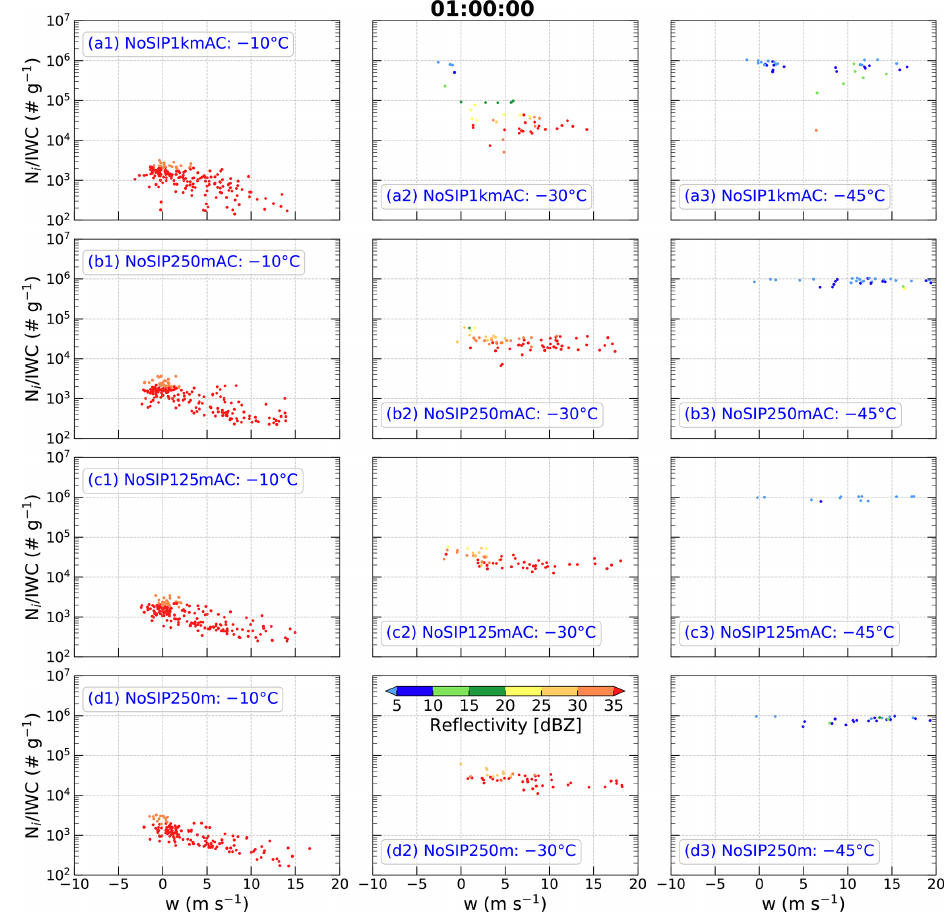
Figure 4. Scatter plots of simulated ice number concentration ( N i , no.m − 3 ) divided by ice water content (IWC, gm − 3 ) (denoted as N i / IWC) as a function of vertical velocity ( w , ms − 1 ) in regions with IWC > 1gm − 3 at temperatures of (left column) − 10 ◦ C, (middle column) − 30 ◦ C, and (right column) − 45 ◦ C at t = 60min in experiments (a1–a3) NoSIP1kmAC, (b1–b3) NoSIP250mAC, (c1–c3) NoSIP125mAC, and (d1–d3) NoSIP250m. The simulations at the three temperature levels are interpolated from the model outputs. The simulations with horizontal grid spacing < 1km have been coarsened to 1km for comparison by spatially averaging with a window size of 1km × 1km. The points are color-coded according to the magnitude of radar equivalent reflectivity factor